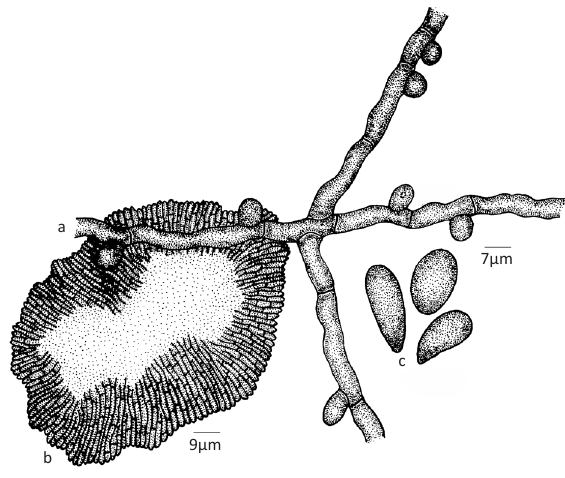
Figure 8. Asterostomella derridicola sp. nov. a - Appressoriate mycelium; b - Pycnothyrium; c - Pycnothyriospores